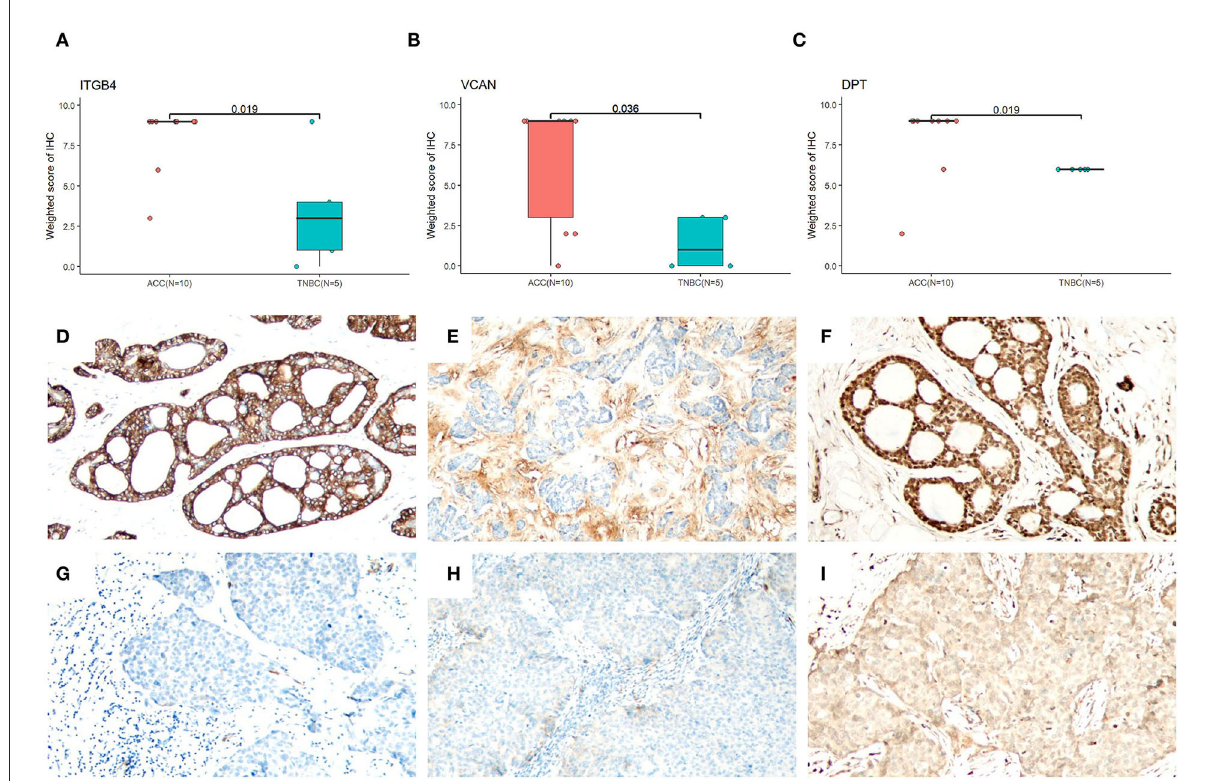
FIGURE4 Evaluation of ITGB4, VCAN, and DPT IHC in ACC and BL-TNBC. Statistic results of the weighted score of IHC (Whitney U test) for ITGB4 (A) , VCAN (B) , and DPT (C) . (D) ITGB4 showing strong membranous expression in ACC (100 × ). (E) VCAN showing diffuse expression in peritumoral stroma of ACC (100 × ). (F) DPT showing strong cytoplasmic and nuclear expression in ACC (100 × ). (G) Completely negative ITGB4 expression in BL-TNBC (100 × ). (H) No VCAN staining in peritumoral stroma staining in BL-TNBC (100 × ). (I) Weak cytoplasmic expression of DPT in BL-TNBC (100 ×